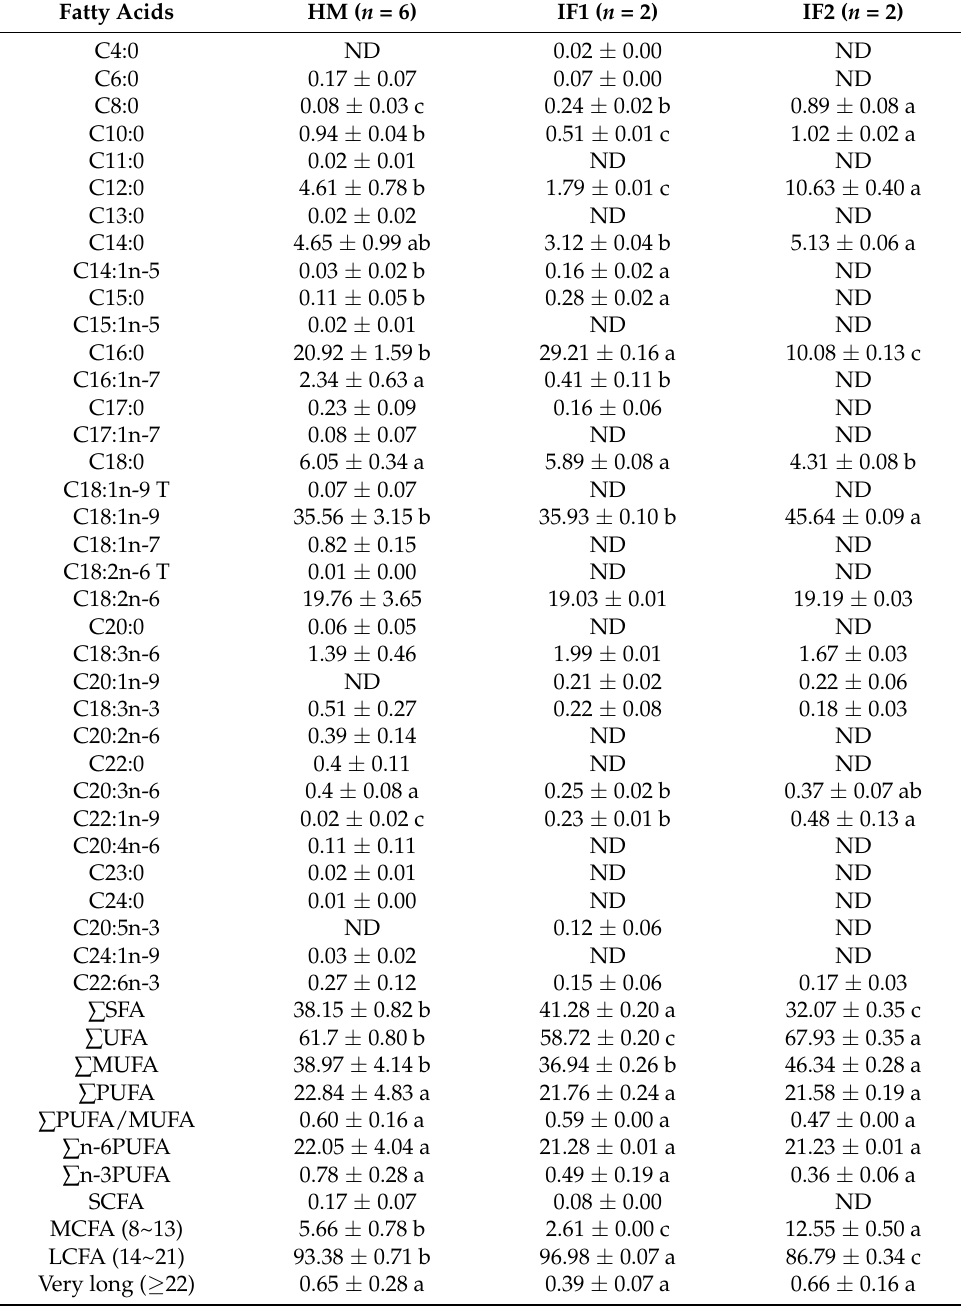
Table 2. Total fatty acids composition of human milk and infant formulas (%, w / w